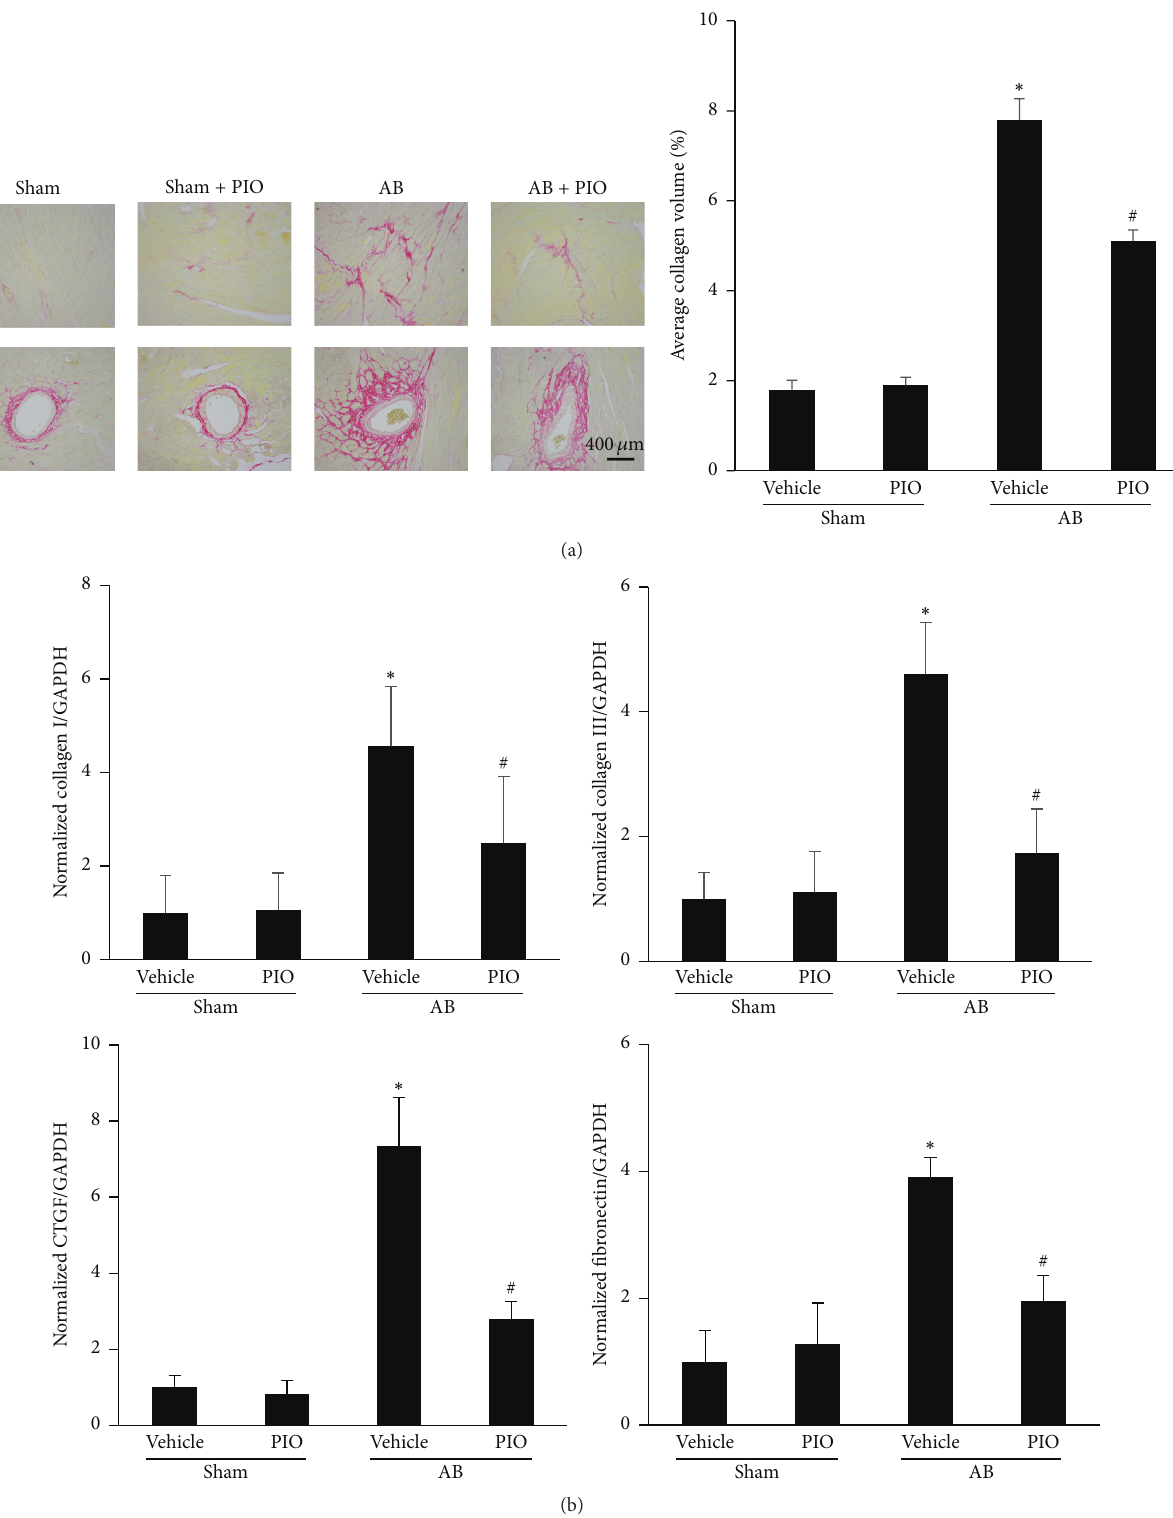
Figure 2: PIO attenuated cardiac fibrosis in vivo. (a) Histological sections of the left ventricle were stained for PSR and average collagen volume in group of AB or sham with or without PIO ( 𝑛 = 4 ). (b) Expression levels of the transcripts for collagen I, collagen III, connective tissuegrowthfactor(CTGF),andfibronectinnormalizedbyGAPDHoftheindicatedgroupsbyreal-timePCR( 𝑛 = 4 ). ∗ 𝑃 < 0.05 ascompared with the corresponding sham group. # 𝑃 < 0.05 versus the AB